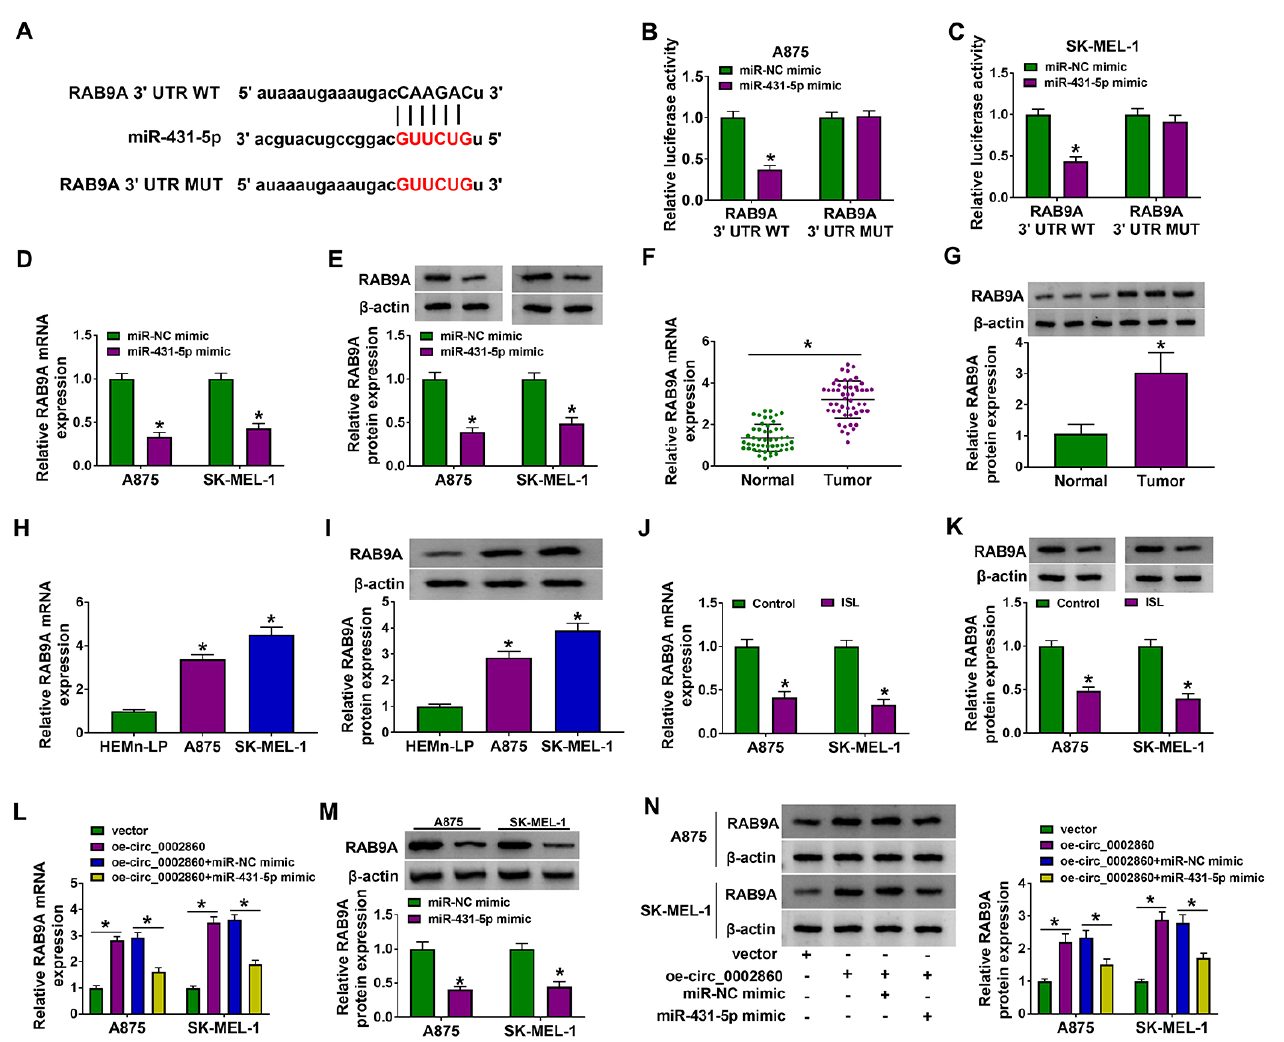
Figure 5. Circ_0002860 sponged miR-431-5p to increase the RAB9A level in melanoma cells. (A) Starbase exhibited the binding site between RAB9A 3’UTR and miR-431-5p. (B, C) The binding between miR-431-5p and RAB9A was identified by dual-luciferase reporter assay. (D, E) The mRNA and protein levels of RAB9A were measured via RT-qPCR and western blot after transfection with miR-NC mimic or miR-431-5p mimic. RAB9A quantification was performed using RT-qPCR and western blot in (F, G) melanoma tissues and (H, I) cells. (J, K) The effect of 60 µg/mL ISL on RAB9A expression was evaluated via RT-qPCR and western blot. (L) RT-qPCR was applied to detect the RAB9A mRNA level in vector, oe-circ_0002860, oe-circ_0002860+miR-NC mimic and oe-circ_0002860+miR-431-5p mimic groups. (M) RAB9A protein level was detected by western blot after transfection of miR-NC mimic or miR-431-5p mimic. (N) RAB9A protein expression was determined by western blot after transfection as Figure 5L. * p <